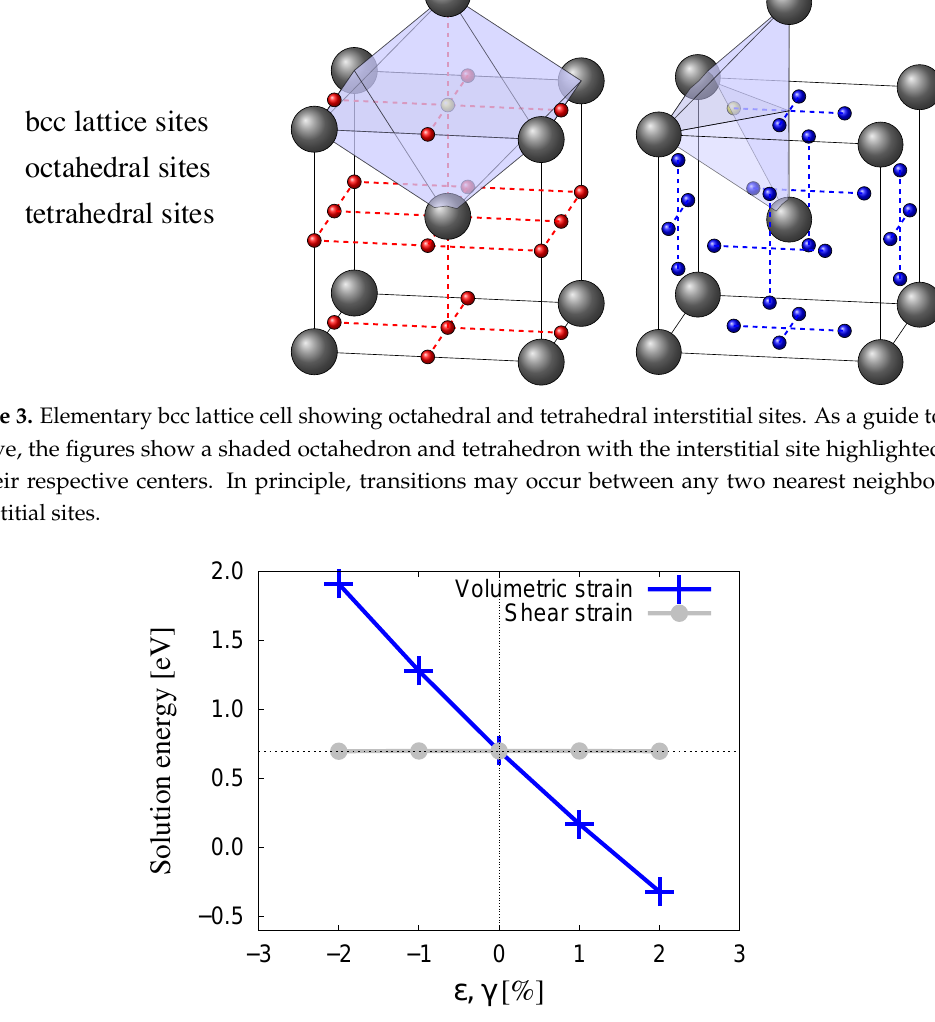
Figure 4. Variation of the heat of solution of tetrahedral O as a function of volumetric, ε , and shear, γ ,